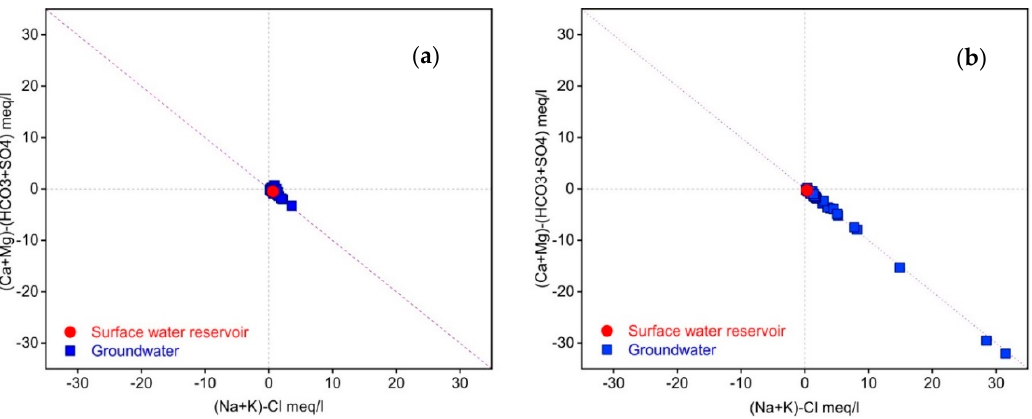
+ SO + K)–Cl for Kierma ( a ) and Mogt é do ( b 3 4 ) vs. (Na